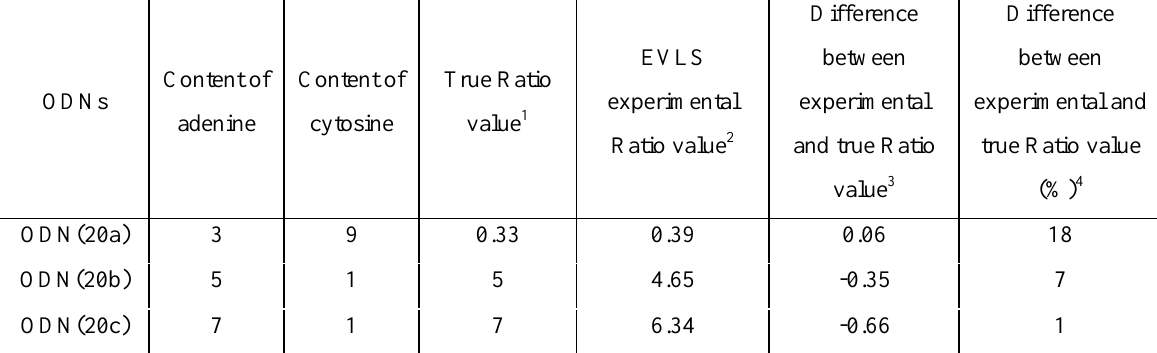
Table 1. Characterization of ODNs (20-mers) by the ratio of A:C in ODNs (pH 5.4).